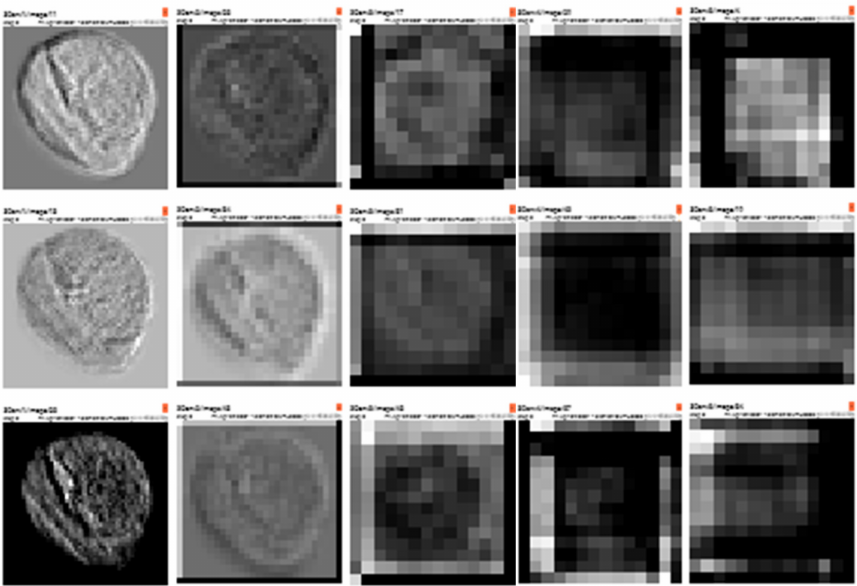
Figure 10. Convolution visualization results of the new network-dr model (the columns of images from left to right represent the results obtained for Convolutional Layers 1–5).